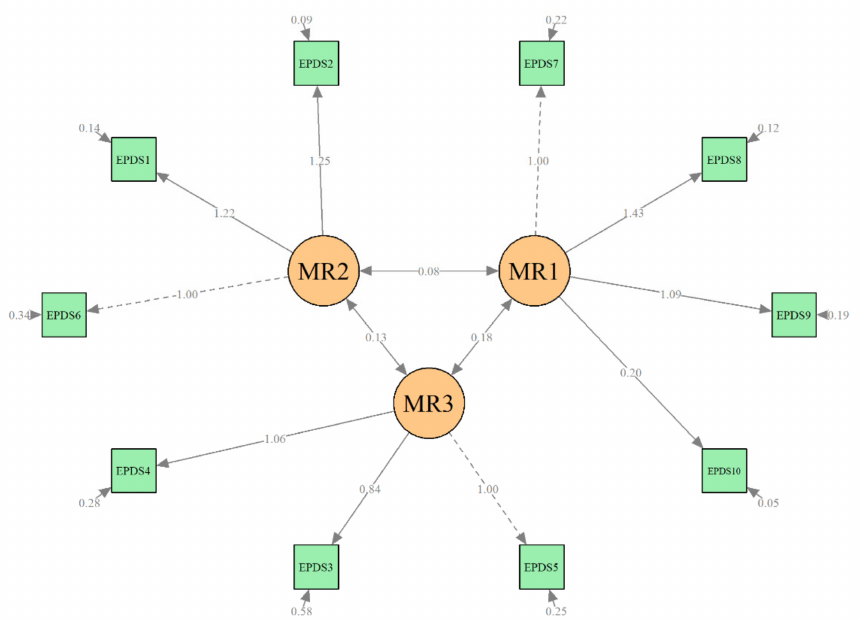
Figure 1. Confirmatory factor analysis of T1 data, 3-factor model (3–4 days postpartum).